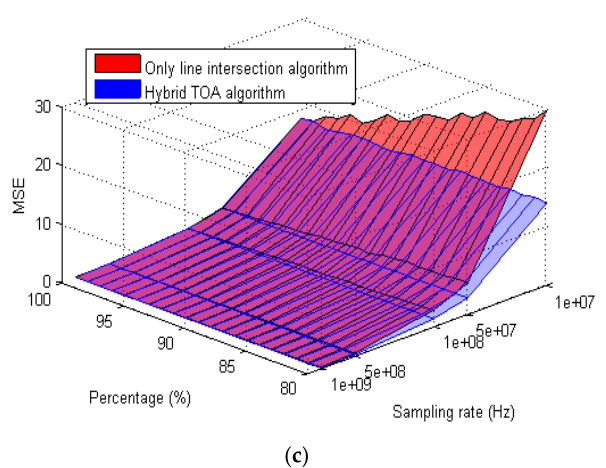
Figure 17. MSE curves for the estimated MS locations based on the hybrid TOA algorithm and only line intersection algorithm, for (a) the first case, (b) the second case, and (c) the third case, for the second set.